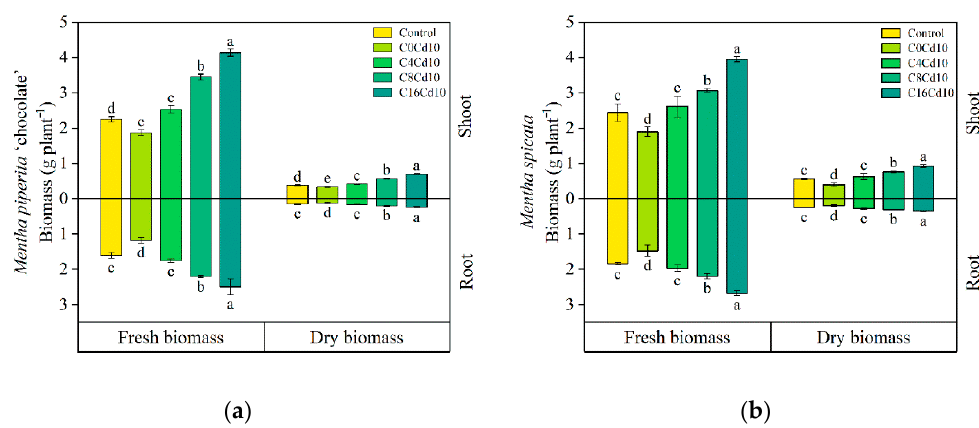
Figure 2. Effect of biochar on the biomass of M. piperita ‘chocolate’ ( a ) and M. spicata ( b ) under Cd stress. Error lines are standard deviations from the mean (n = 3) and different letters indicate significantly different values between treatments, p < 0.05.